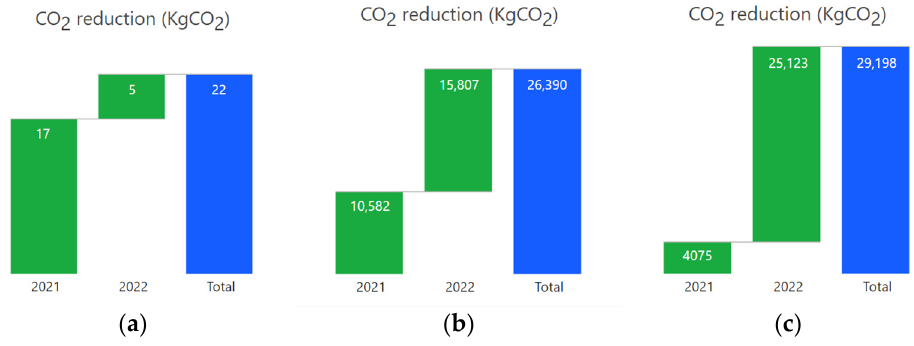
Figure 5. CO 2 emissions reductions of ( a ) Operation 1, ( b ) Operation 2, and ( c ) Operation